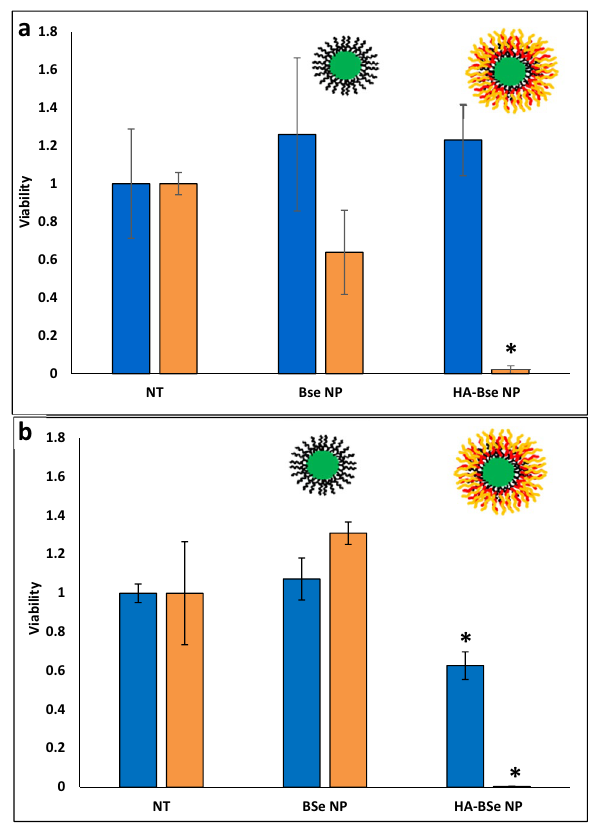
Figure 5. HA-BSe NP photothermal activity in 3D. ( a ) Reduction in organoid viability following treatment with ablative HA-BSe NPs + Laser relative to non-targeted BSe NPs and no nanoparticles (NT-no treatment) with and without laser exposure. *indicates a significant difference between HA-BSe NPs + Laser and both the No Treatment and HA-BSe NPs + No Laser. (Error bars reported as s.e.m.) ( b ) CT26 cells incubated for 1 hr with BSe NPs or HA-BSe NPs prior to the formation of organoids and subsequent laser exposure indicate complete ablation of the cells with HA-BSe NPs plus